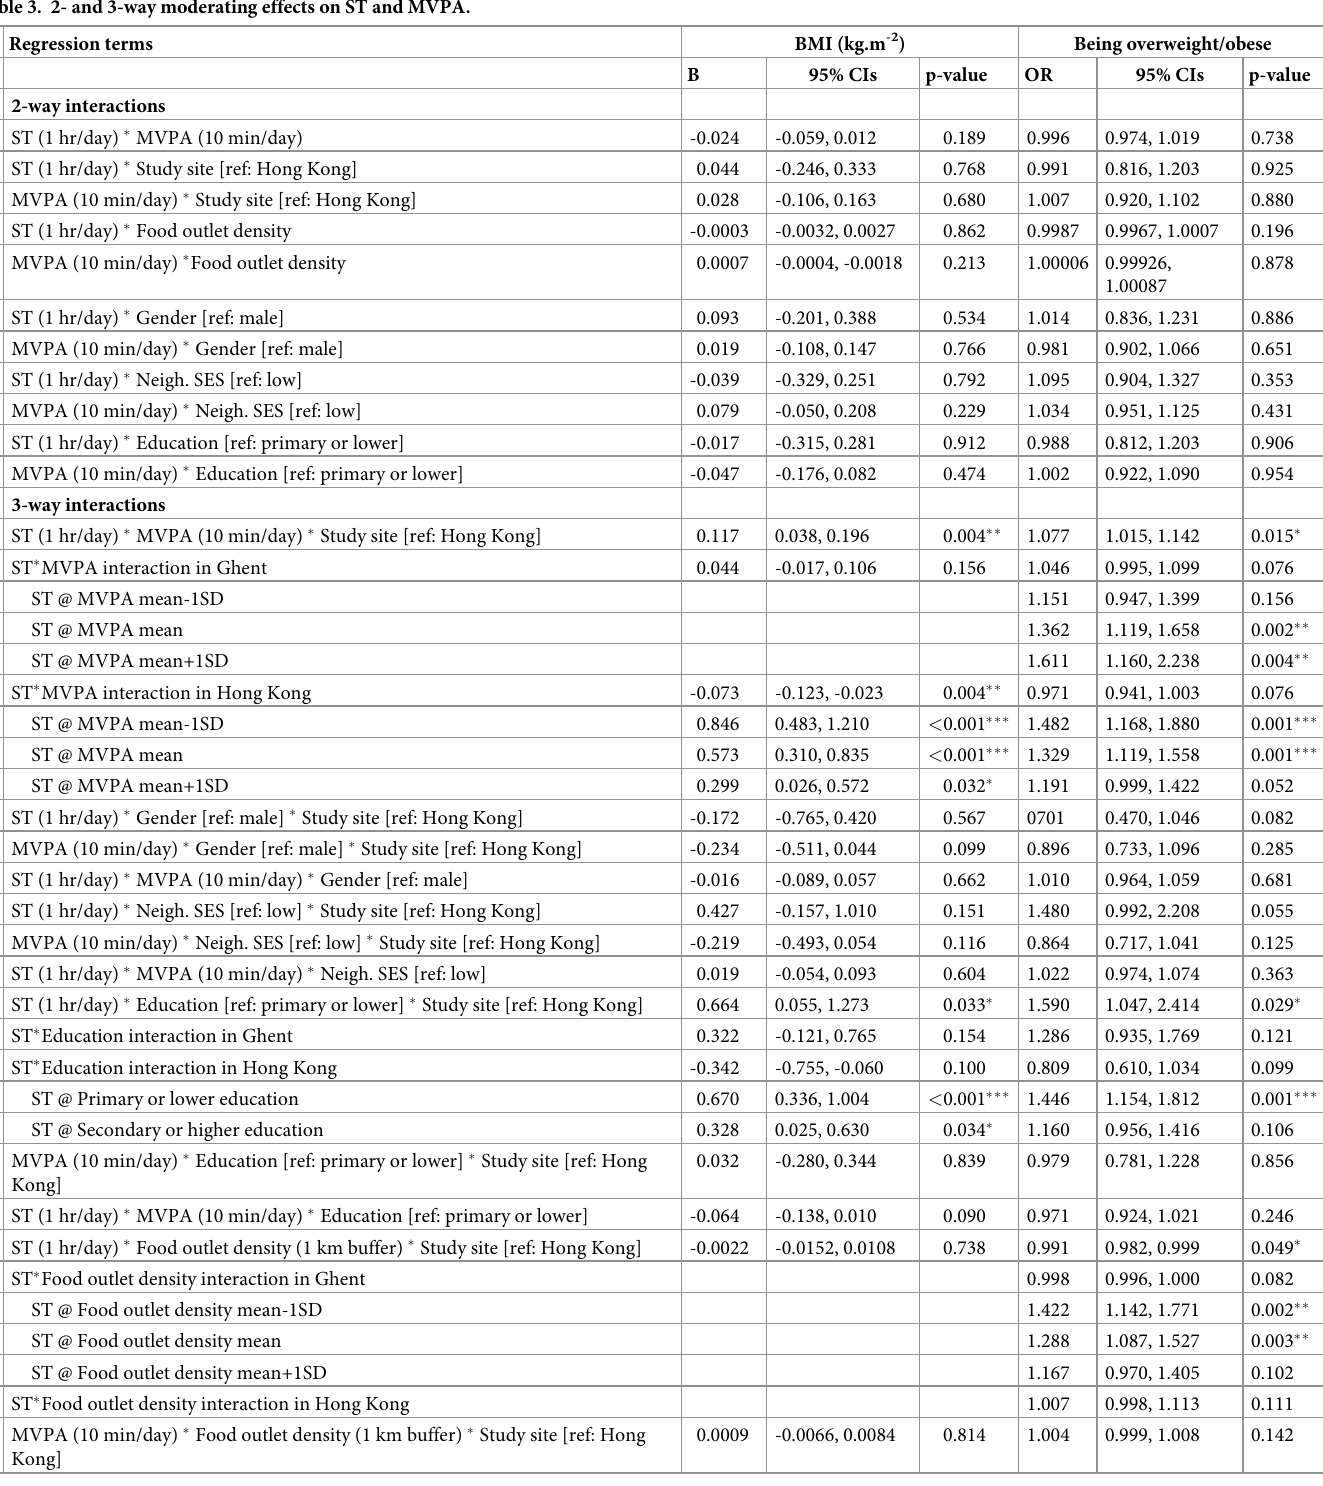
Table 3. 2- and 3-way moderating effects on ST and